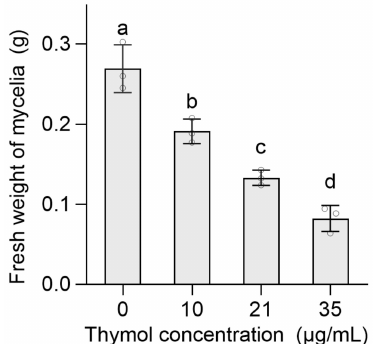
Figure 2. Effect of thymol on the fresh weight of mycelia of FON . The FON was cultured in PDB medium containing thymol (0, 10, 21, and 35 µ g/mL) for 120 h, followed by the measurement of mycelial fresh weight. Bars indicated SD of three replicates. Different lowercase letters indicated significant difference among different treatments (LSD, n = 3, p <